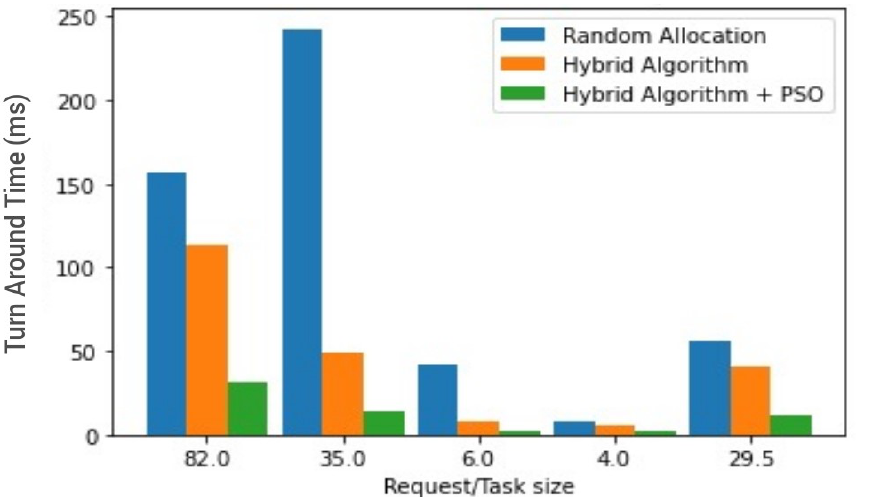
Figure 12. Random Resource allocation vs. hybrids resource allocation vs. PSOR2B